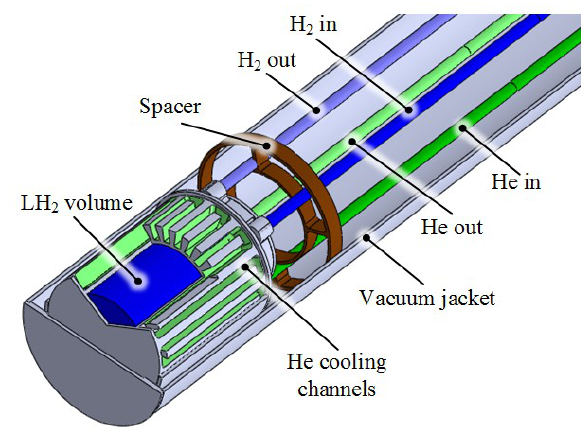
Figure 3. CAD model of the cryogenic moderator assembly. located inside its vacuum jacket.